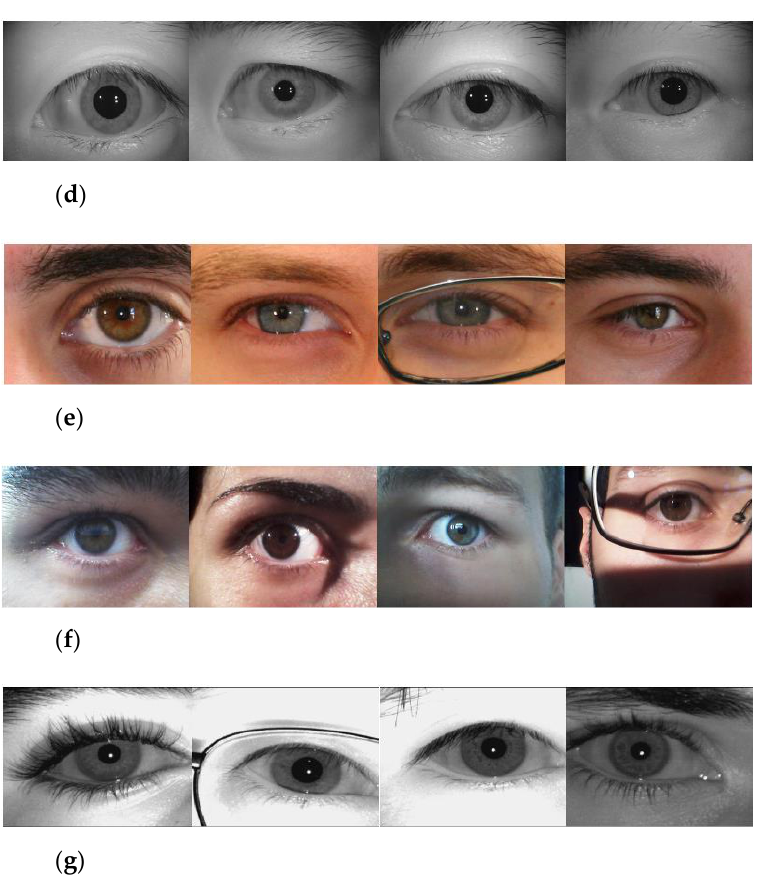
Figure 7. The samples of seven iris datasets: ( a ) JLU-6.0; ( b ) JLU-7.0; ( c ) CASIA-Iris-Interval-v4; ( d ) CASIA-Iris-Lamp-v4; ( e ) UBIRIS.V2; ( f ) MICHE-I; ( g ) Mmu2.